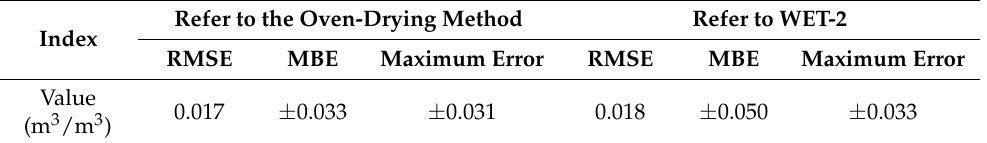
Table 2. Indoor measurement accuracy verification test results of self-developed moisture sensor.